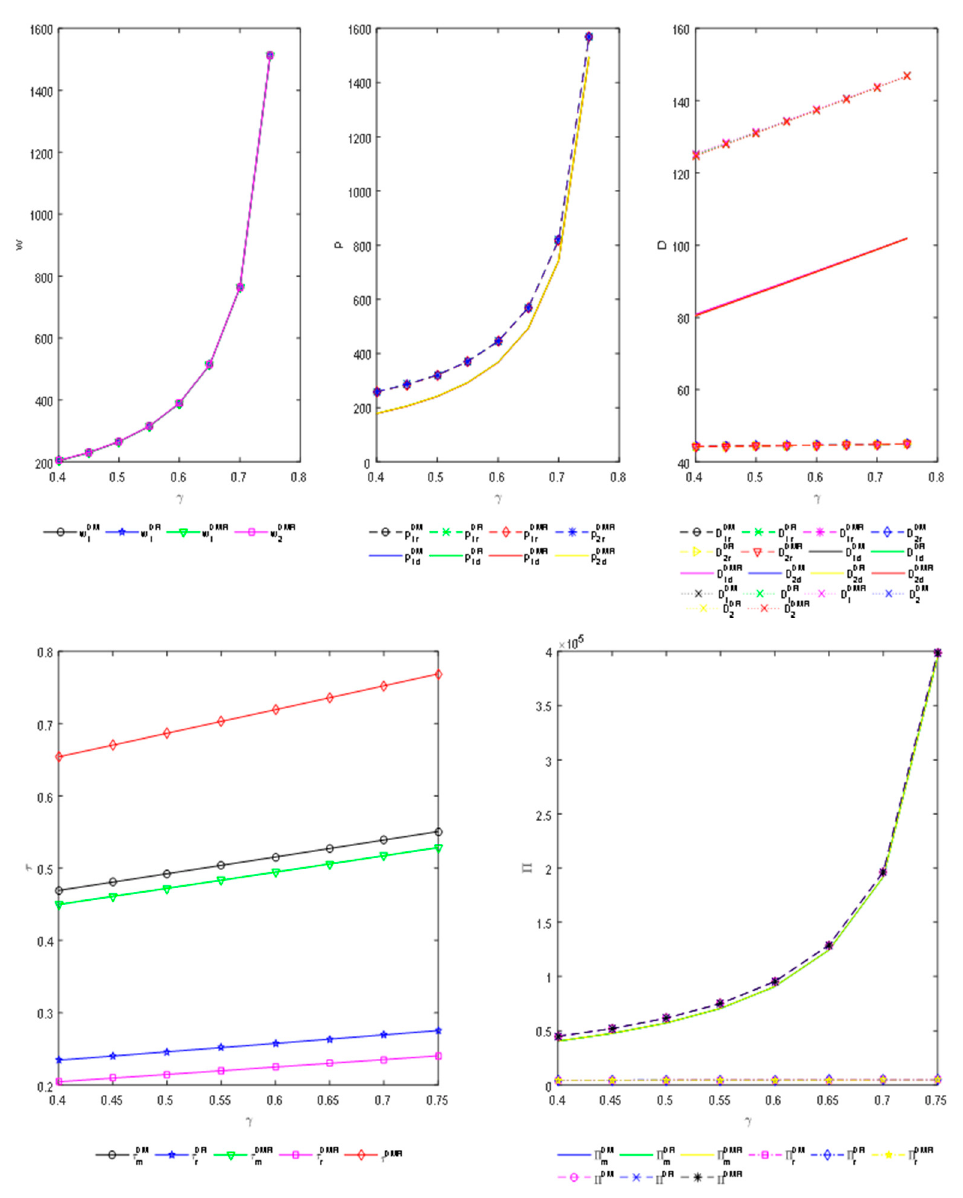
Figure 6. Changes of the wholesale price/selling price/market demand/collecting rate/profit with γ .